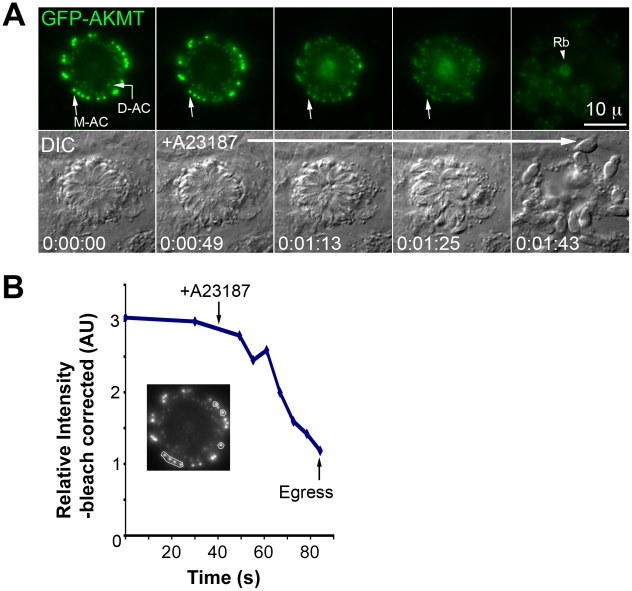
Elevated [Ca2+] triggers the dispersal of AKMT from the apical complex before A23187 induced parasite egress.(A) Images show the result from a time-lapse experiment of intracellular Δakmt parasites expressing eGFP-AKMT(WT) treated with 5 µM A23187 (A23187 was added between 0∶00∶30 and 0∶00∶49). These parasites were in the process of daughter construction as indicated by the two internal AKMT positive spots (daughter apical complexes: D-AC) in addition to the AKMT labeling in the mother apical complex (M-AC) of each parasite (c.f.
Figure S1C). These parasites are connected through a structure in the central region called the residual body (Rb, arrowhead) [4]. Upon treatment with A23187, eGFP-AKMT relocated from the mother apical complex to the parasite body, followed by parasite egress. The residual body, containing some of the eGFP-AKMT released from the apical complex, is left behind. (B) Plot of average intensity (bleach-corrected) of eGFP-AKMT over time for seven mother apical complexes (encircled in the gray-scale image) in the experiment shown in A, showing the dissociation of AKMT from the mother apical complex before parasite egress. AU: Arbitrary Unit.